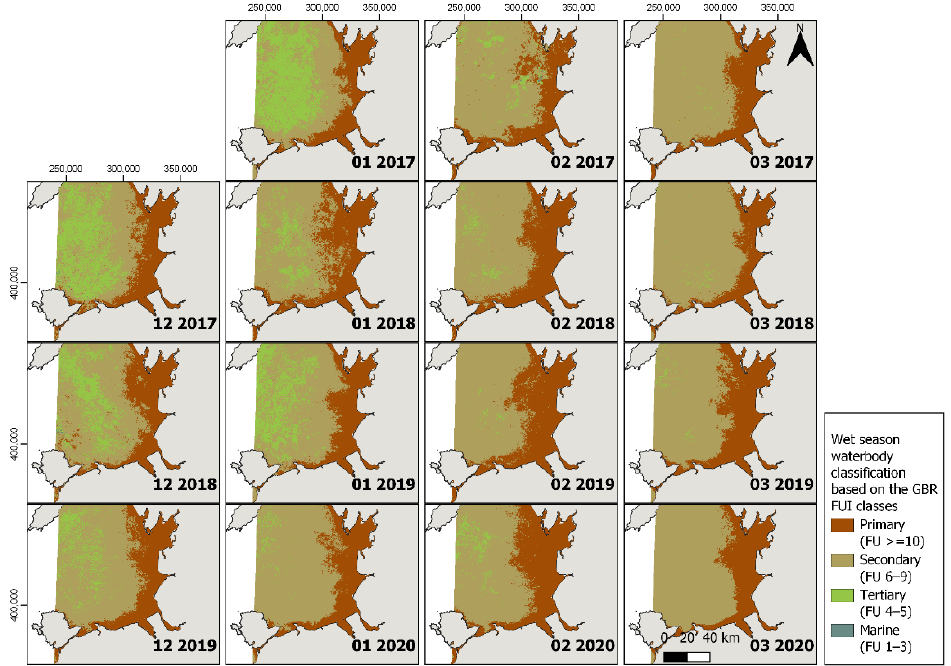
Figure 6. Classification of Liverpool Bay wet season (December, January, February, March) according to the four GBR waterbody classes based on FUI values. The river plume areas across the wet season between 2017 – 2020 do not change significantly across the months. Table 2. Descriptive statistics for the annual and seasonal river plume area (km 2 ) between 2017 – 2020 in Liverpool Bay, showing the average, maximum (Max), minimum (Min), standard deviation (STD) and the average per season per year.